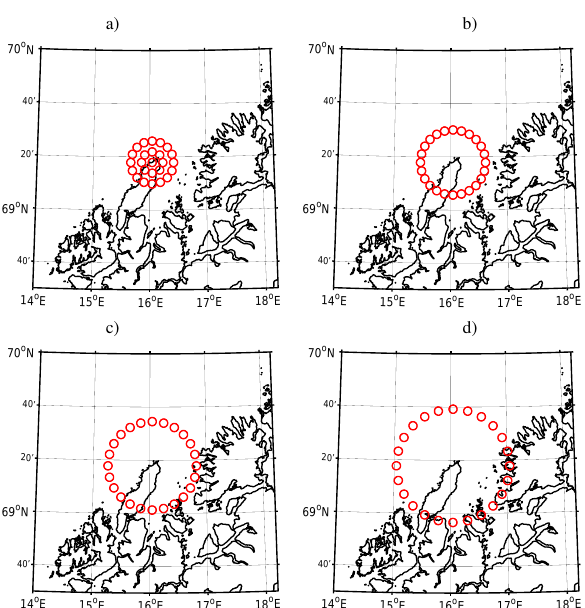
27 Fig. 2. The multi-beam sequence is conducted using four ex- periments with 25 beams each. The black contour lines indicate the Northern Norwegian coast line. The red circles represent the beam positions assuming a 3.6 ◦ beam width at 84km. The labels a,b,c,d correspond to the experiments meso006a25,